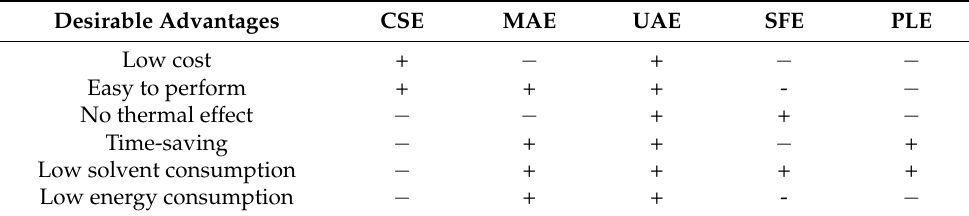
Table 3. Practical comparison of the desirable advantages among the considered extraction ap-